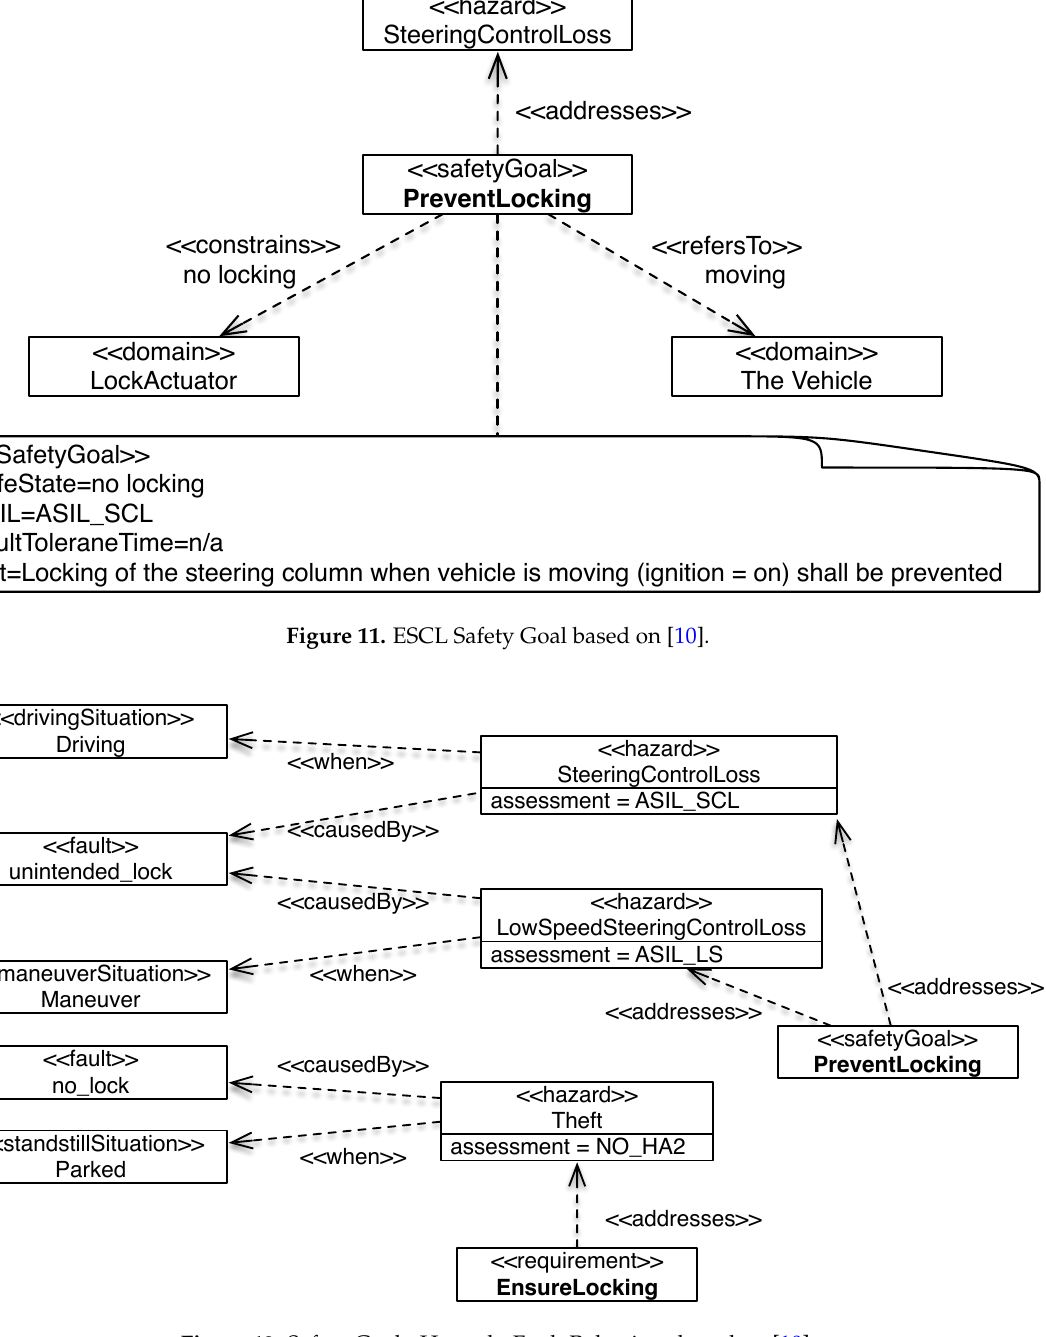
Figure 12. Safety Goal - Hazard - Fault Relataions based on [10]. Table 4. Safety Goal-Hazard-Fault Relataions based on